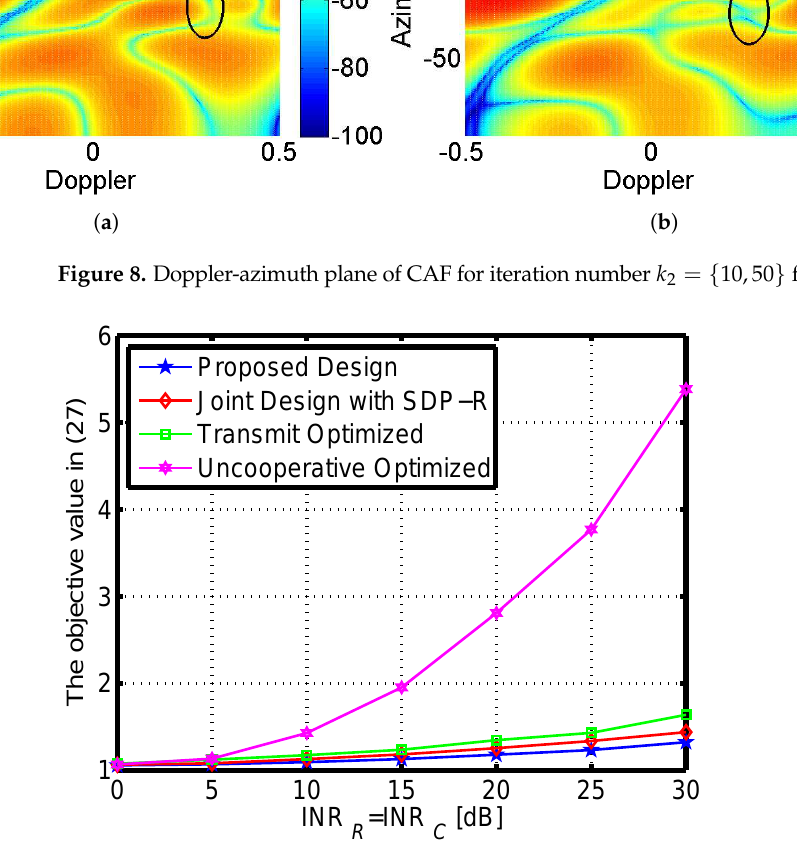
Figure 9. The objective value under different INR R = INR C of mutual interference for channel